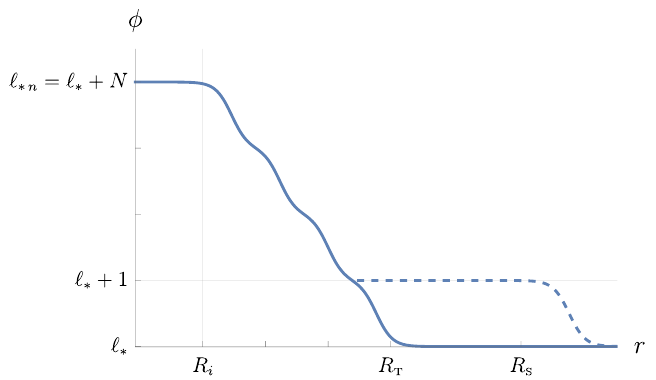
Figure 5 . N (cid:29) 1 bubble in equilibrium at R ∼ R from the star